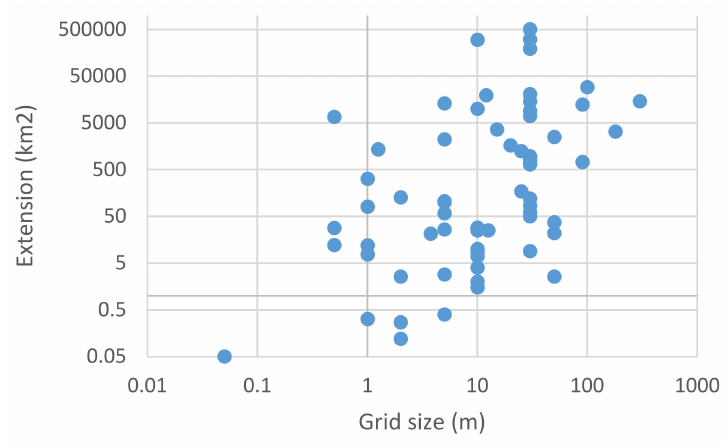
Figure 6. Log-log representation of the relationship between extension (Km 2 ) and grid size